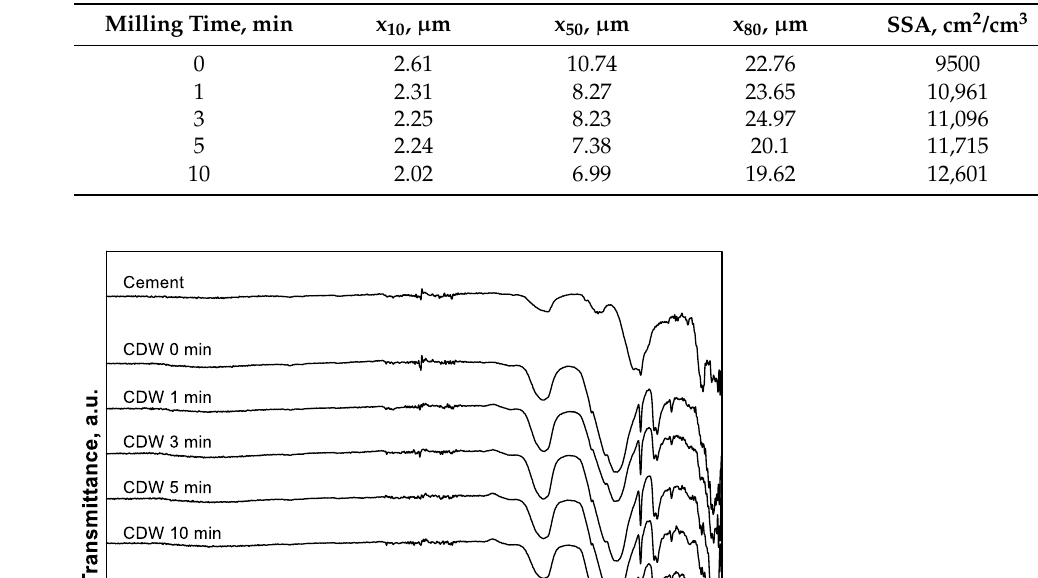
Table 2. The characteristic particle size and SSA values of the ground cement stones.